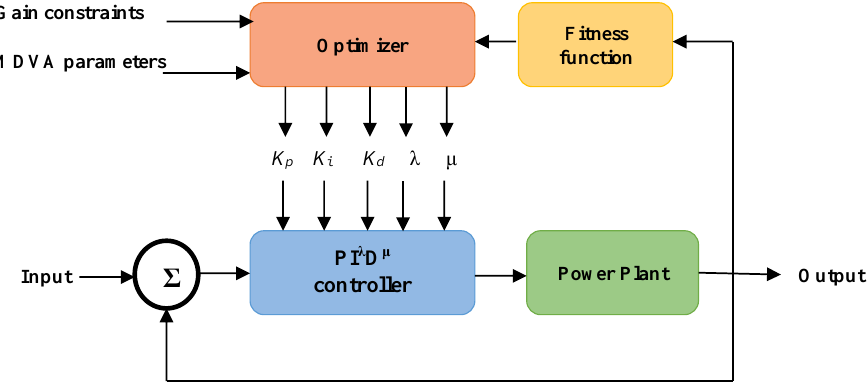
Figure 4. The proposed structure of FOPID-LFC controller optimized via optimization algorithm.